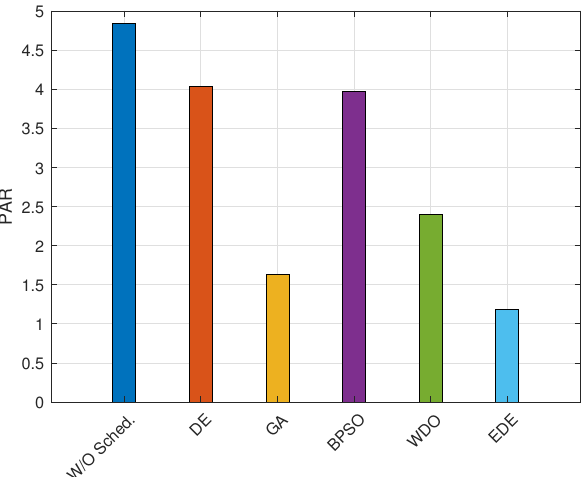
Figure 16. PAR minimization evaluation after scheduling noninterruptible appliances.